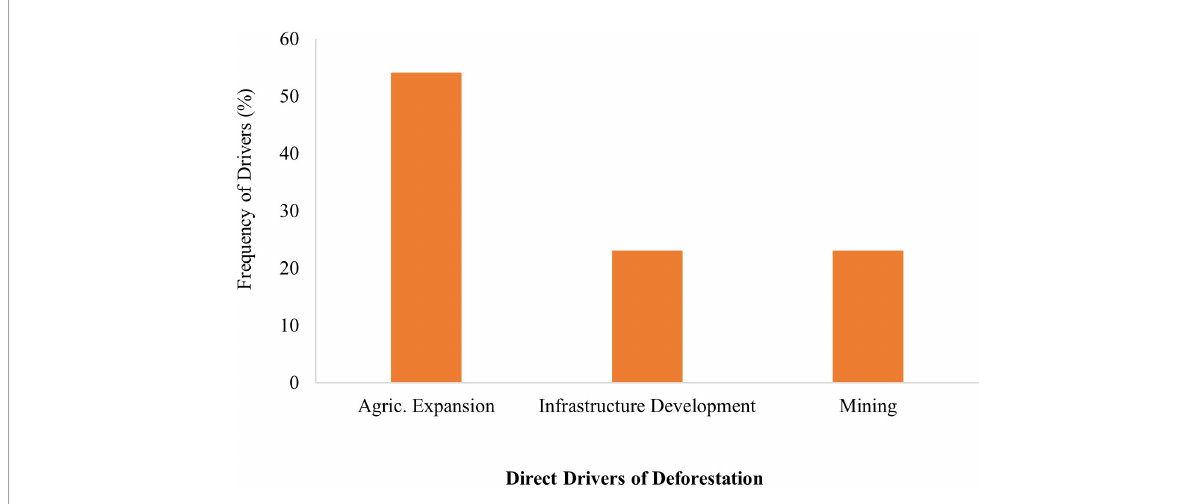
FIGURE3 Direct deforestation drivers in 29 participant countries according to policymakers’ accounts.